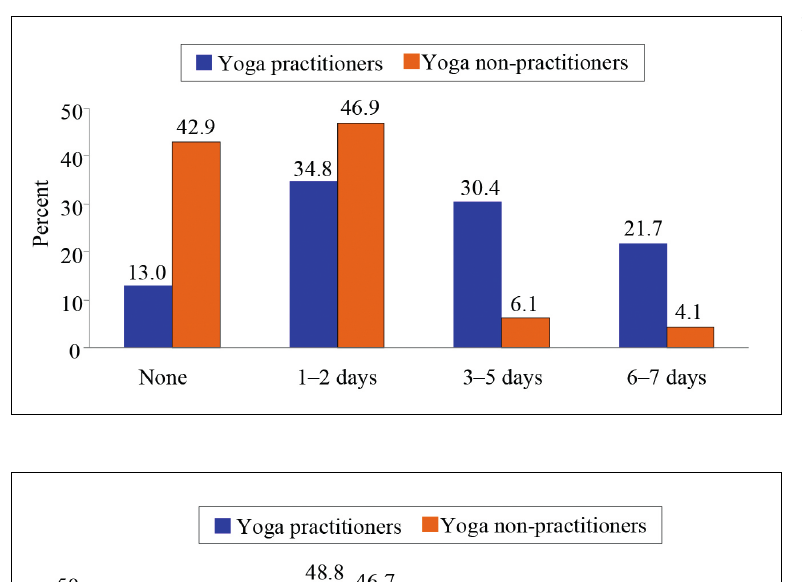
.05.Figure 7. Pattern of time devoted to physical activity in groups of yoga practitioners and non-practitioners